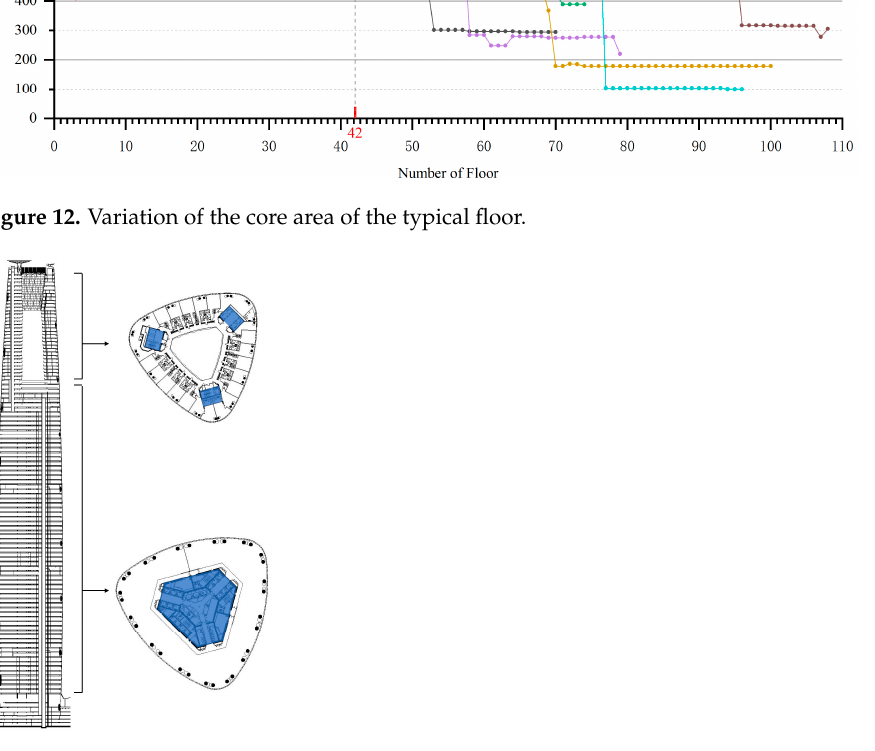
Figure 13. Schematic diagram of the core of Guangzhou International Finance Center.